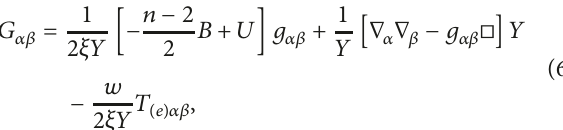
̇𝑏(𝑥)/𝑏(𝑥) (b) Relationof 𝐻(𝑥) = , 𝑍(1) = 1.0041022218 ; 𝐻(1) = 1 isthe current value of the Hubble constant. ̃𝐵 𝑛 = 144.517022939 , 𝑘 2 = −0.4